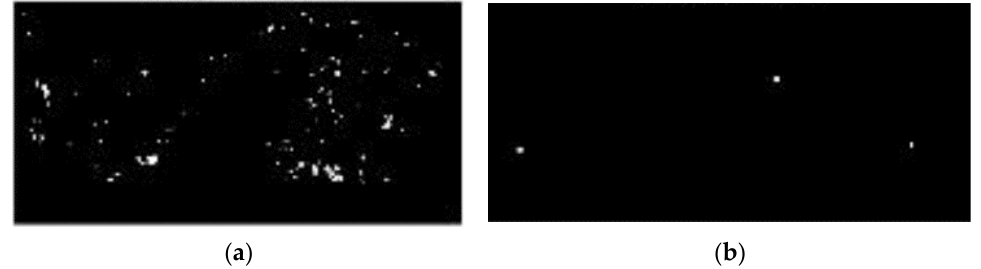
Figure 18. The image of plastic sheet and generated holes after image processing, ( a ) no mesh was used (experiment 19 in Table 1), ( b ) mesh was used (experiment 20 in Table 1). used (experiment 19 in Table 1), ( b ) mesh was used (experiment 20 in Table